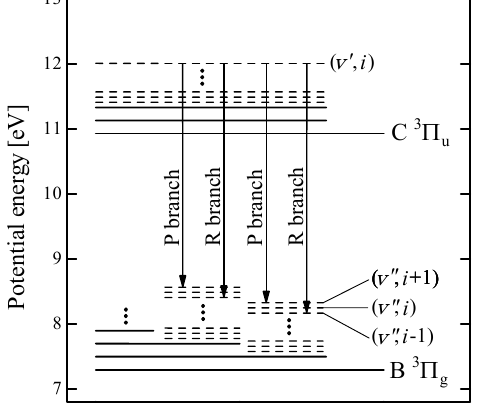
Fig. 4 Model of radiative transition